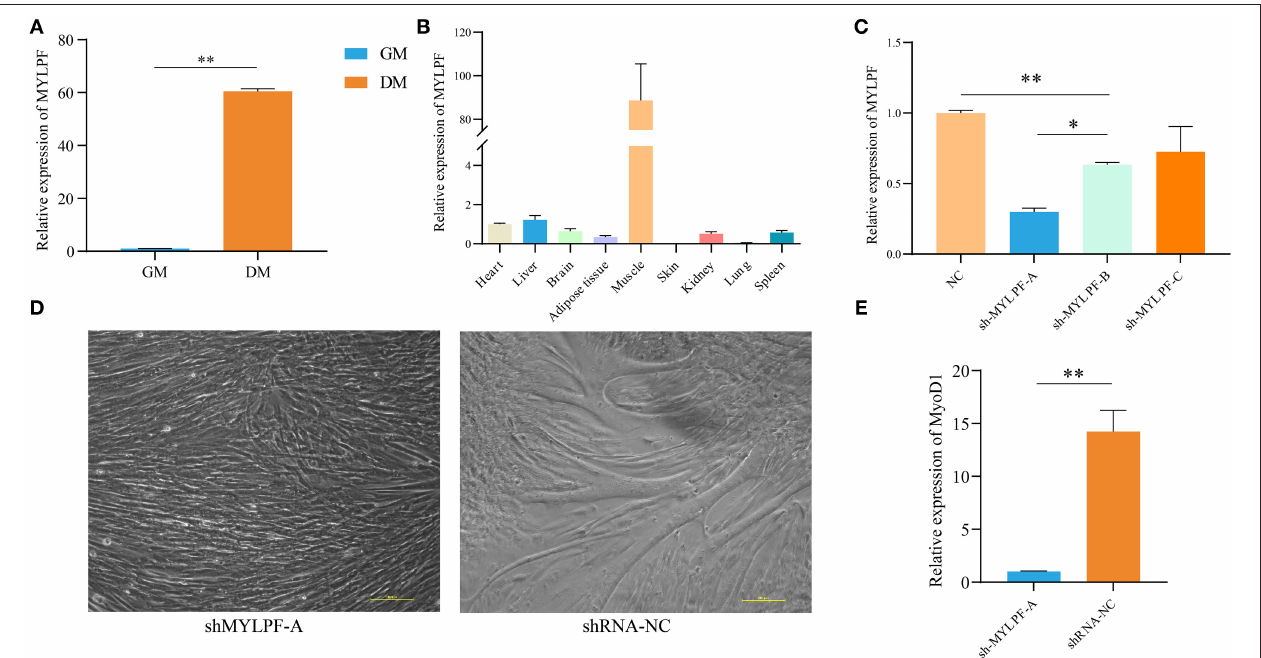
FIGURE 6 | Expression and characterization of MYLPF in buffalo skeletal muscle. (A) Validation of the expression of MYLPF by RT-qPCR. (B) The expression levels of MYLPF in different tissues of buffalo. (C) The interference efficiency of MYLPF was measured by RT-qPCR. (D) Inhibition of MYLPF expression on myotubule formation. (E) The mRNA expression of myogenesis marker gene, MyOD1 , was measured by RT-qPCR. The data are presented as means ± SDs, n = 3 per group. * P < 0.05; ** P < 0.01. Scale bars = 100 µ